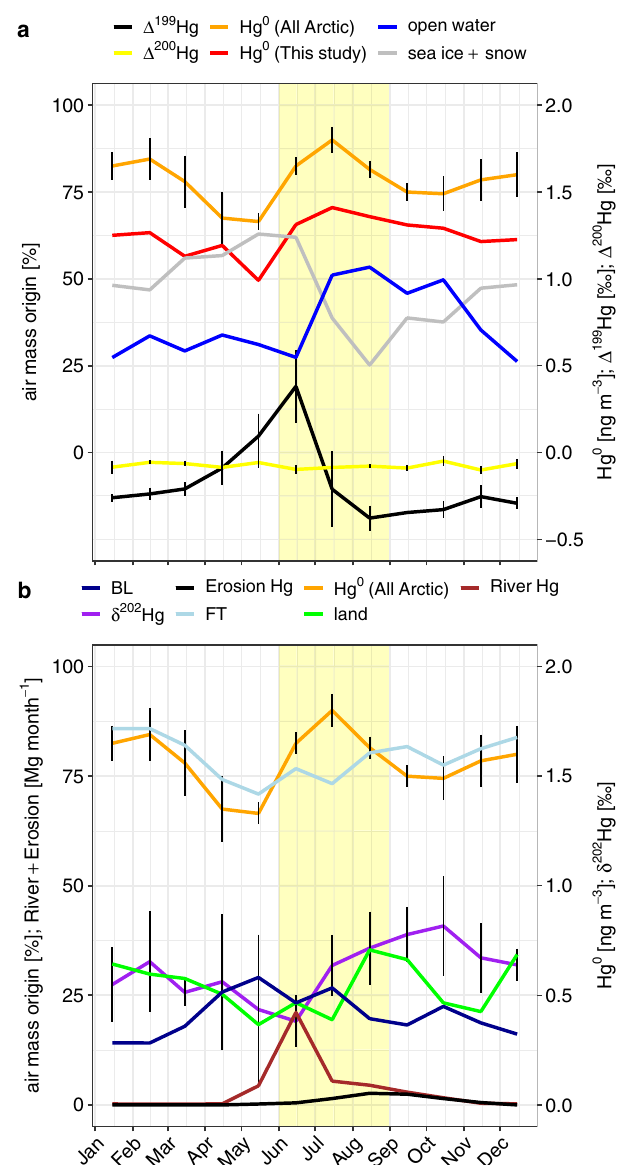
Fig.5|MeanmonthlyvariabilityinArcticatmosphericHgandairmassorigins. a Mean monthly atmospheric Hg 0 at Zeppelin (ZEP), Alert (ALT) and Amderma (Russia) stations from 2000 to 2009 (orange line), and mean monthly Hg 0 (red line), Δ 199 Hg(blackline)and Δ 200 Hg(yellowline)forZEP,Villum(VRS)andALTfrom thisstudyfor2018 – 2019.Meanmonthlyairmassoriginsintheboundarylayer(BL), in%,for10-dayHYSPLITairmasstrajectoriesendingatZEP,VRSandALTareshown for sea ice+snow-covered land (gray line) and open water (blue line). b Mean monthly δ 202 Hg (purple line), air mass origins over land (%, green line), in the free troposphere (FT, %, lightblue line), boundary layer (BL, %, darkblue line), and monthly pan-Arctic River and coastal erosion Hg inputs (Mg month − 1 ). The vertical yellow shaded bar indicates the broad summertime Hg 0 maximum. Error bars represent the 2SD uncertainty for Δ 199 Hg and SD uncertainty for Hg 0